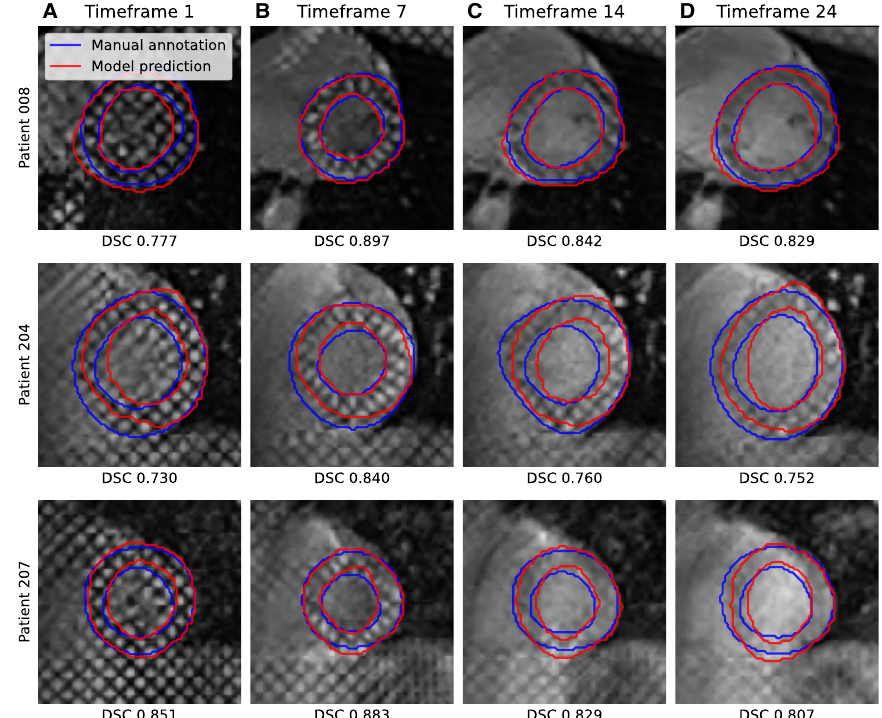
Figure 10. Example segmentations of acquired tagged CMR images from three patients from the test set for image frames 1, 7, 14, and 24 (respectively displayed in columns A – D ) and associated DSC performance scores. The model predictions are generated by the neural network with the ResNetVAE architecture and CycleGAN pretraining strategy.